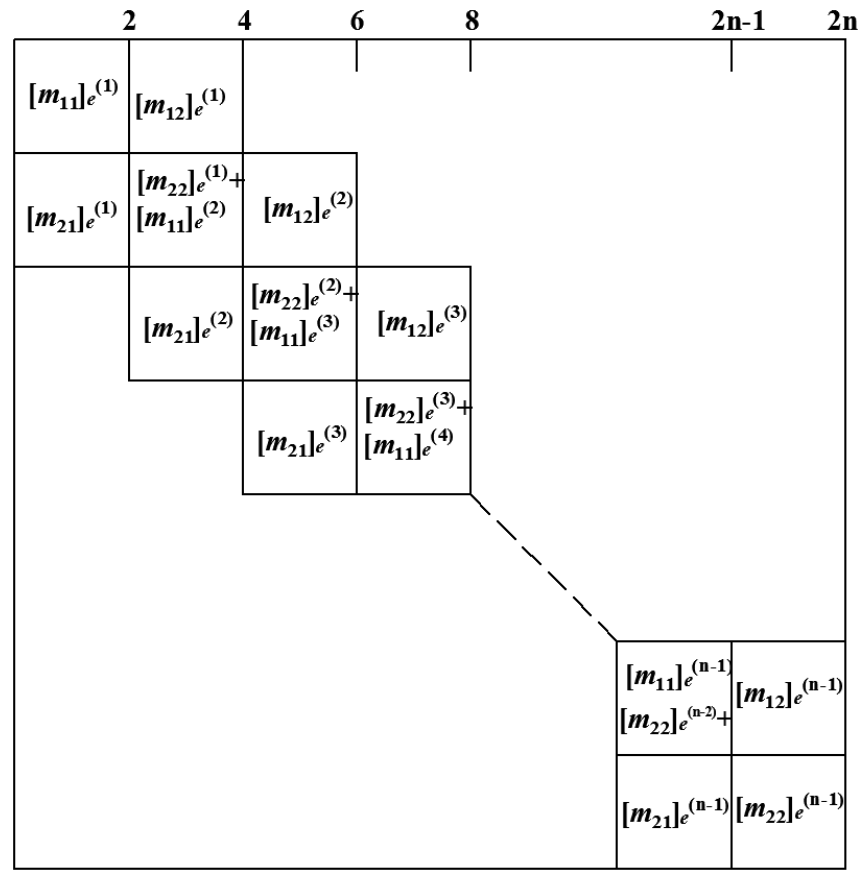
Figure A1 Assembly form of mass matrix M Figure A1. Assembly form of mass matrix M